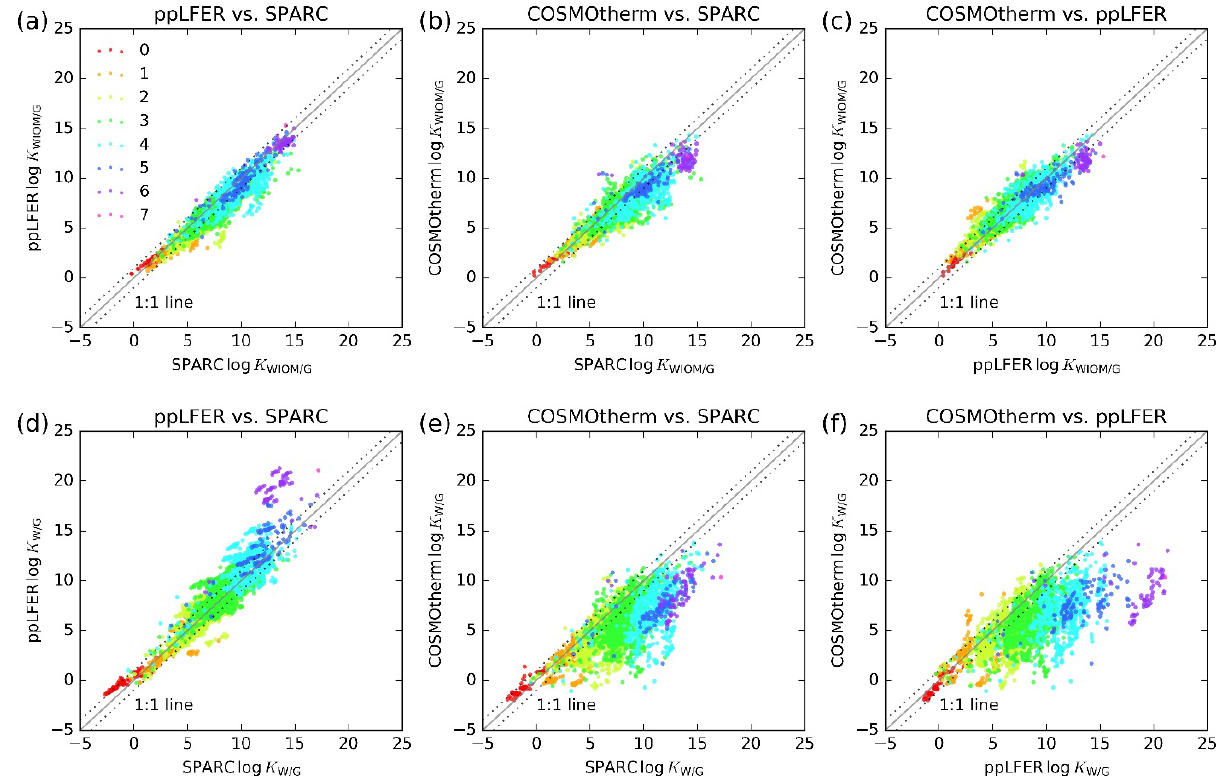
Figure 1. Comparison of the K WIOM/G (upper panel) and K W/G (lower panel) predicted using COSMOtherm, SPARC, and ABSOLV– ppLFERs. The differently colored dots indicate the number of functional groups in the molecules. The solid line indicates a 1:1 agreement. The dotted lines indicate a deviation by ± 1 log